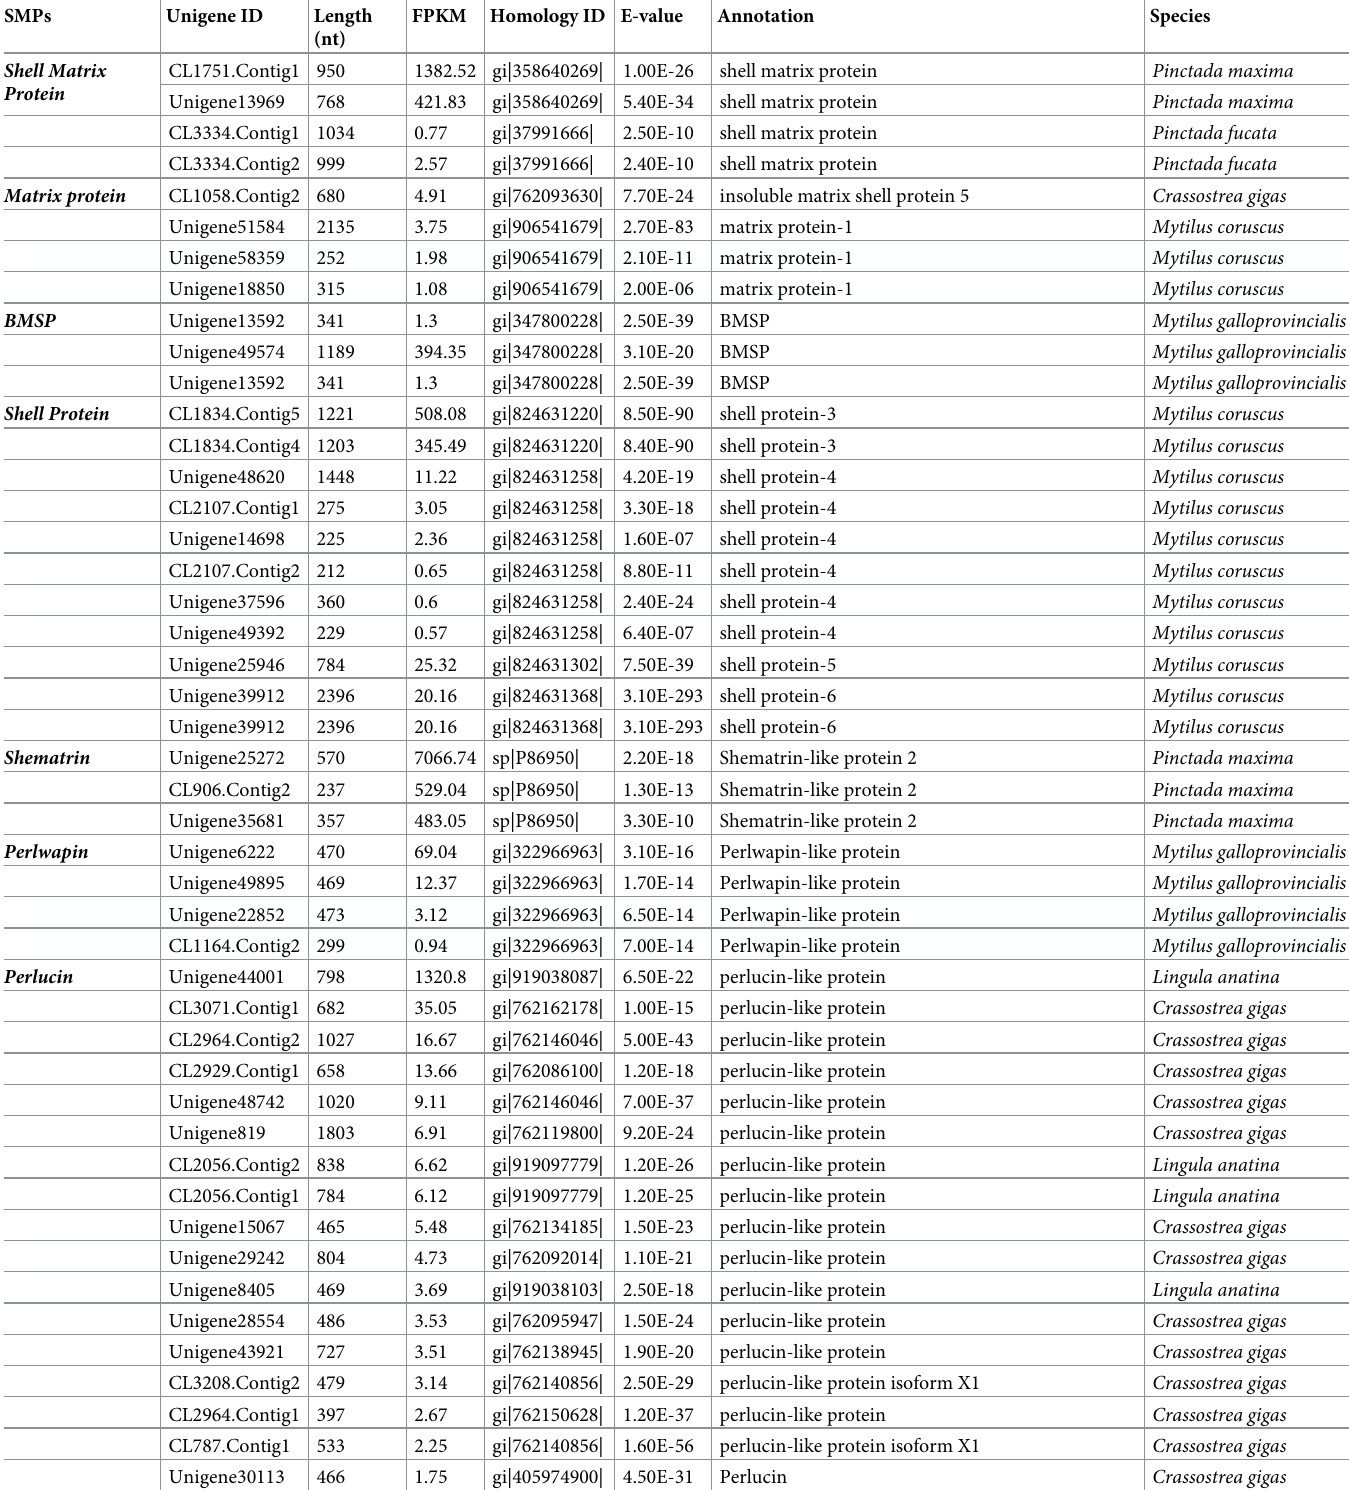
Table 1. The candidate mantle transcripts involved in biomineralization from P . viridis mantle.